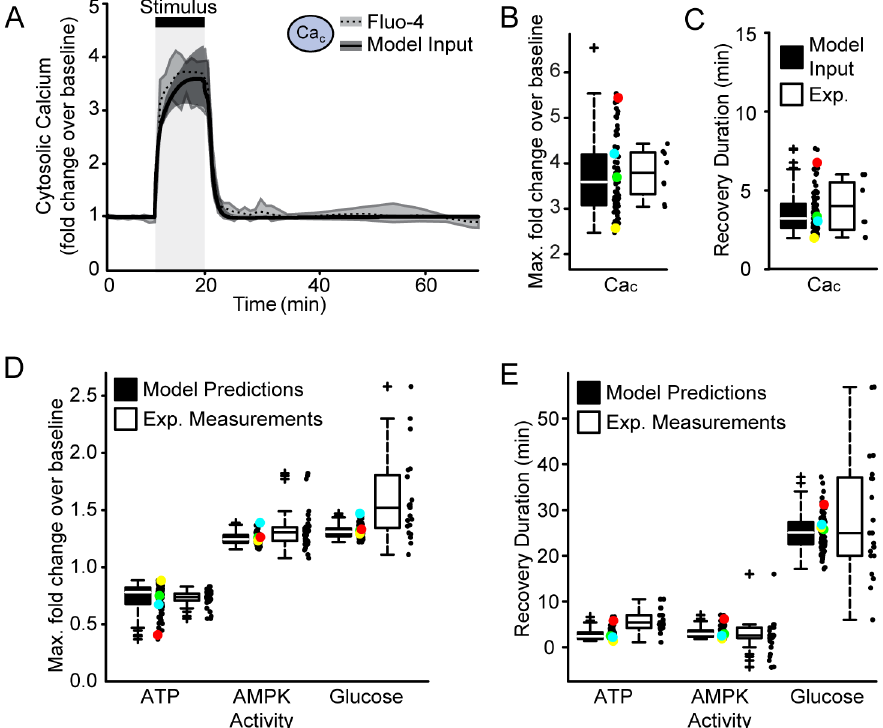
Fig 2. Multiple model simulations with varied parameter sets represented the experimental cell-to-cell heterogeneity. (A-E) Cell-to-cell heterogeneity was modelled by varying parameter values and input characteristics (magnitude and duration of the applied calcium influx) and performing multiple simulations. (A) The median and inter-quartile regions of all model inputs (solid black line within dark grey region) well resembled the median and inter-quartile regions (black dotted line within light grey region) of previously published fluorescent measurements of cytosolic calcium [Ca c ; [15]]. (B-E) For each simulation, the metrics shown in (B-E) were calculated. The coloured data points link these simulations across the figures. The green data points were predicted with the parameter set as listed in Tables 1 and 2. The parameter sets predicting the yellow, cyan and red data points are listed in S2 Table. (B,C) The predicted variability in the (B) maximum fold change and (C) recovery duration of the model input (black box) closely matched experimental measurements (white box). Recovery duration was calculated as the time taken for the signal to recover to ± 2% of baseline signal. (D) Box- and scatter-plots of the minimum ATP, maximum AMPK activity and maximum glucose fold changes during the excitotoxic stimulus, calculated from multiple model predictions and experimental measurements (Exp.) from [15]. (E) Box- and scatter-plots of the post-excitotoxicity recovery duration of the ATP, AMPK activity and glucose levels as calculated from model predictions and experimental measurements (Exp.) from [15].